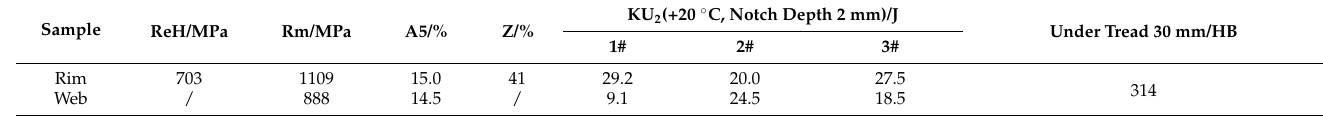
Table 4. Mechanical properties of